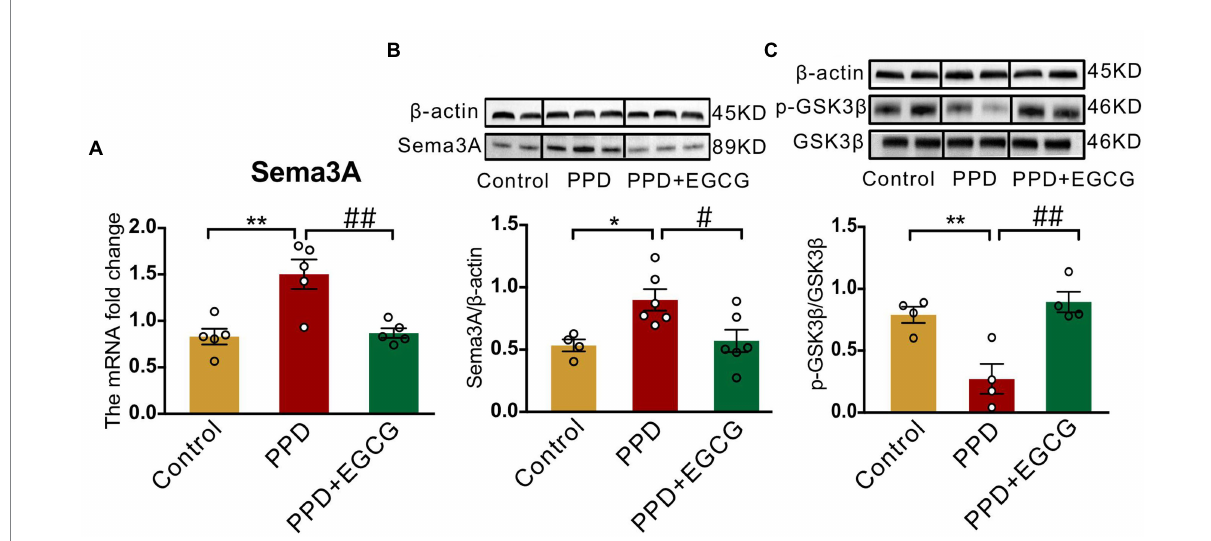
FIGURE 6 EGCG inhibited the hippocampal expression of Sema3A and promoted GSK3 β phosphorylation. (A) The Sema3A mRNA level in the hippocampus of each group. The protein levels of Sema3A (B) and p-GSK3 β (C) in the hippocampus of the three groups. Full-length blots are presented in Supplementary Figure 3. Data were mean ± SEM. White circles represent individual data points. * p < 0.05; ** p < 0.01 vs. Con; # p < 0.05; ## p < 0.01 vs. PPD.